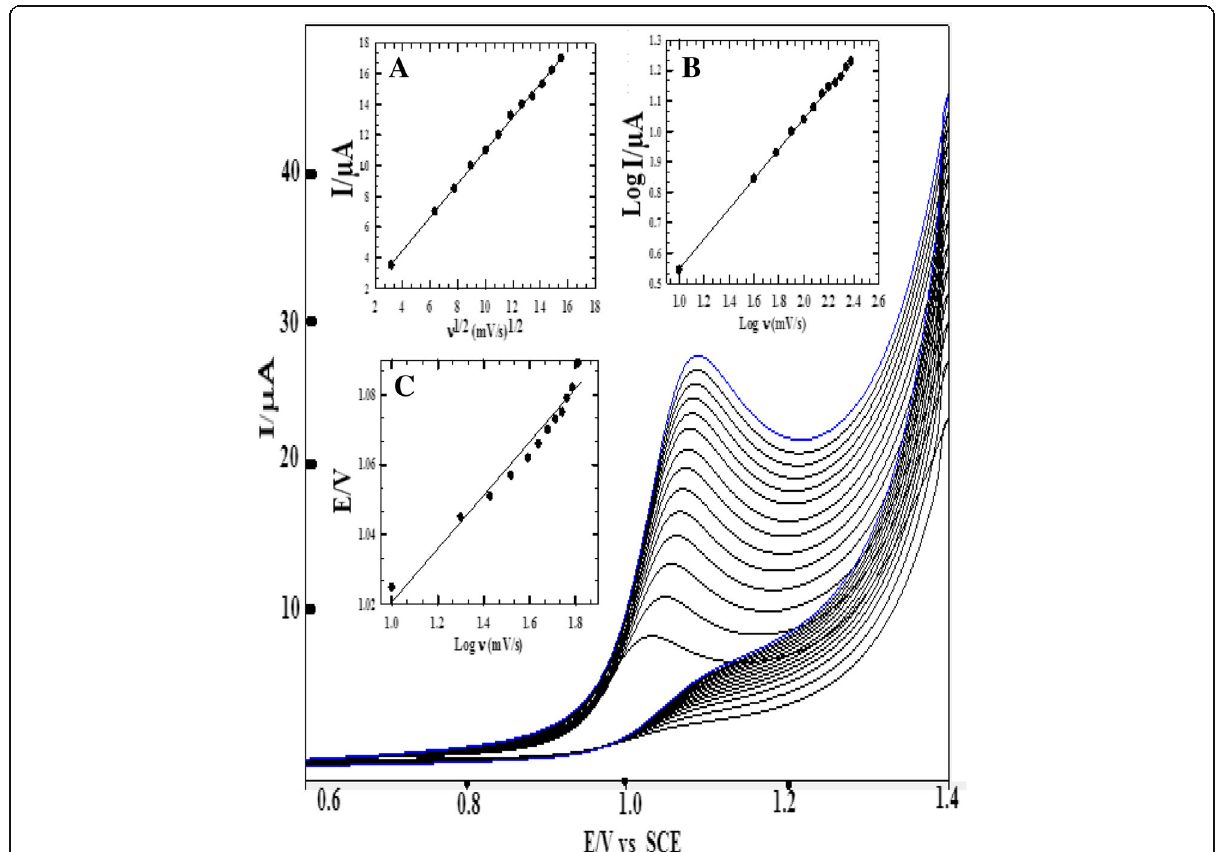
Fig. 4 Effect of varying the scan rate on 1.0 mM LG at CPE/Fe 2 O 3 NPs in B – R buffer pH 7.4 using cyclic voltammetry. Inset a: Plot peak current versus square root of scan rate. Inset b: Plot of log peak current versus log the scan rate. Inset c: Plot of peak potential versus log the scan